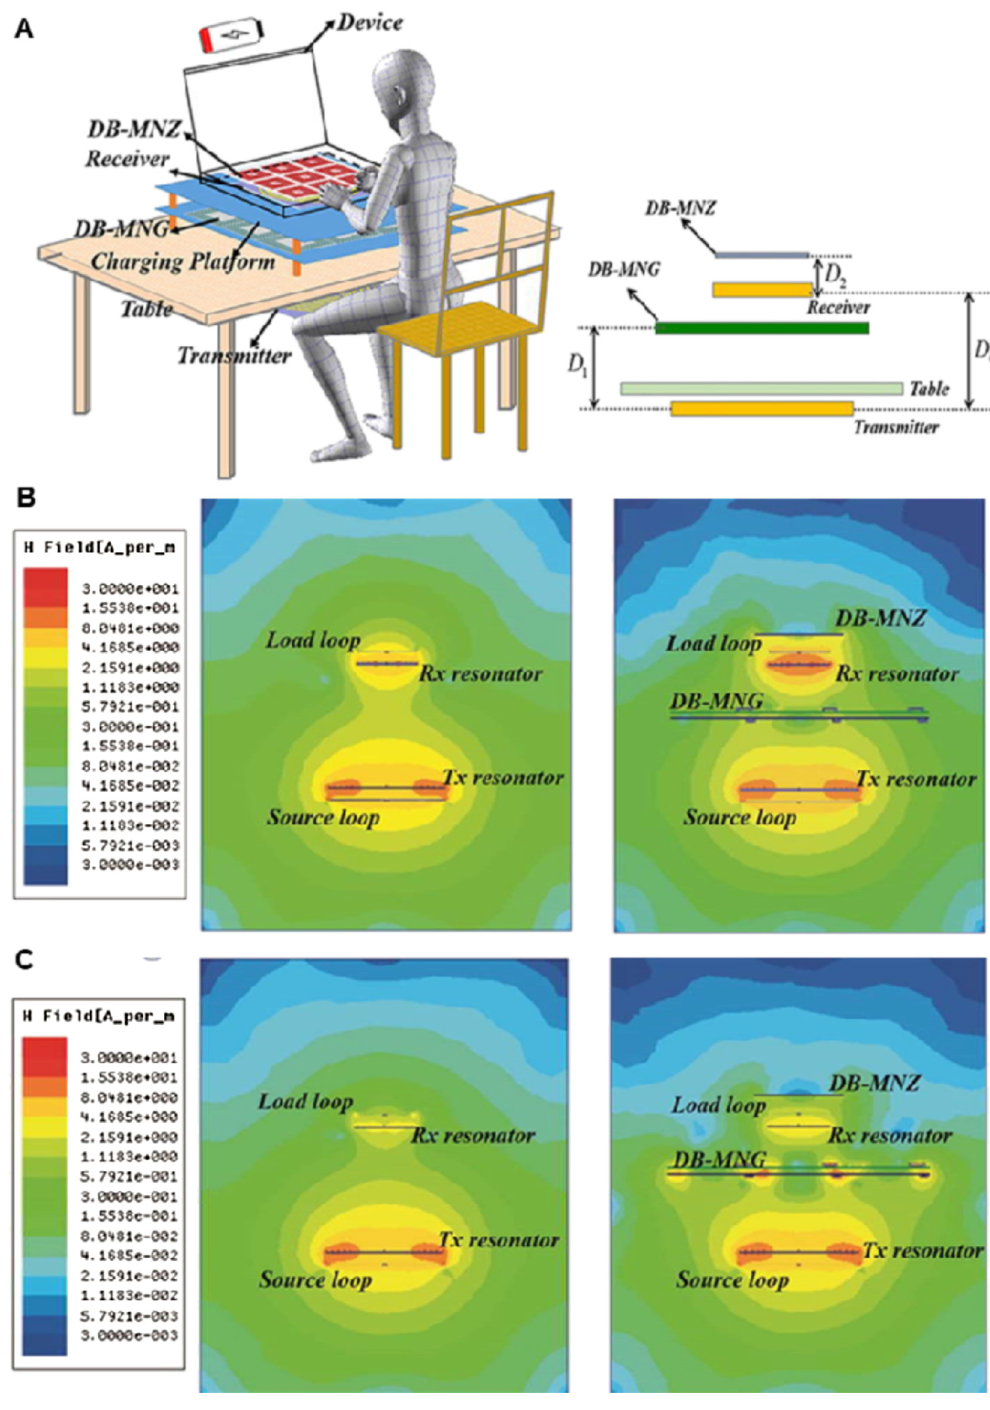
Figure 11: Relay-enhanced metamaterials for coupling WPT. (A)WPTsystemintegratingwiththedual-frequencynegativepermeabilityandnear-zeropermeabilitymetamaterials.(B)and(C)Magnetic fi eld distribution at 13.56 and 27.12 MHz, respectively [77]. Reprinted from [77], with the permission of IEEE